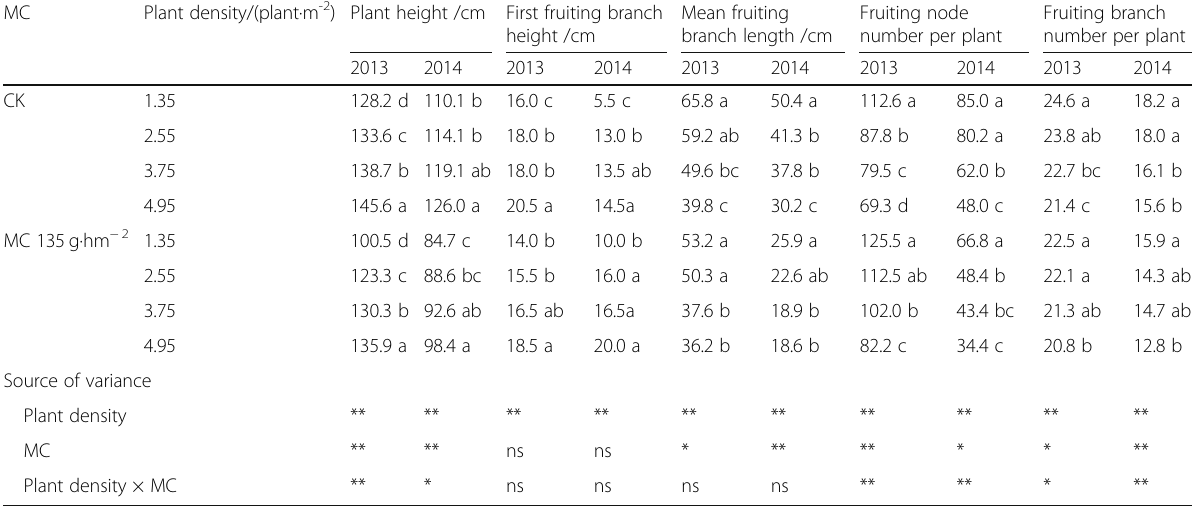
Table 1 Agronomic traits at boll opening stage as affected by mepiquat chloride (MC) and plant densities in Sikang 1 MC